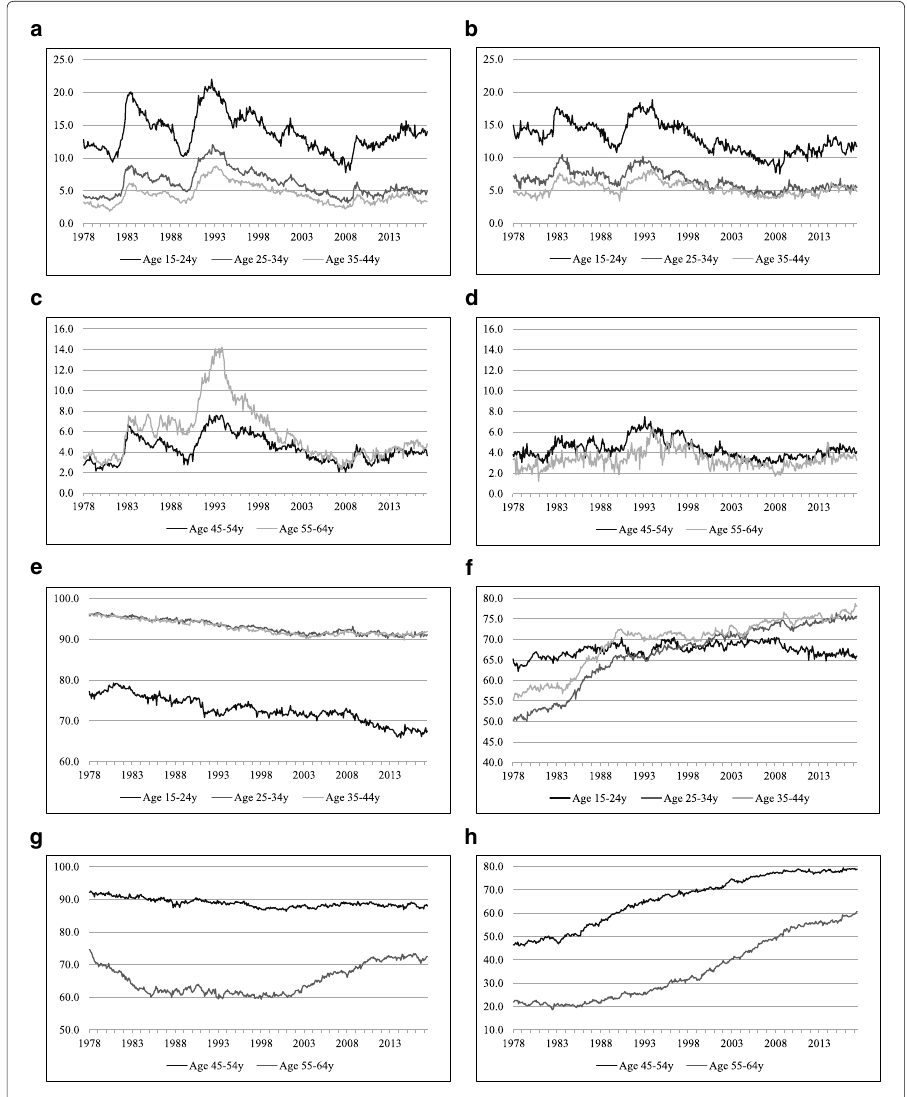
Fig. 1 Historic unemployment and participation rates by age bracket. a Male unemployment rate (age 15–44 years). b Female unemployment rate (age 15–44 years). c Male unemployment rate (age 45–64